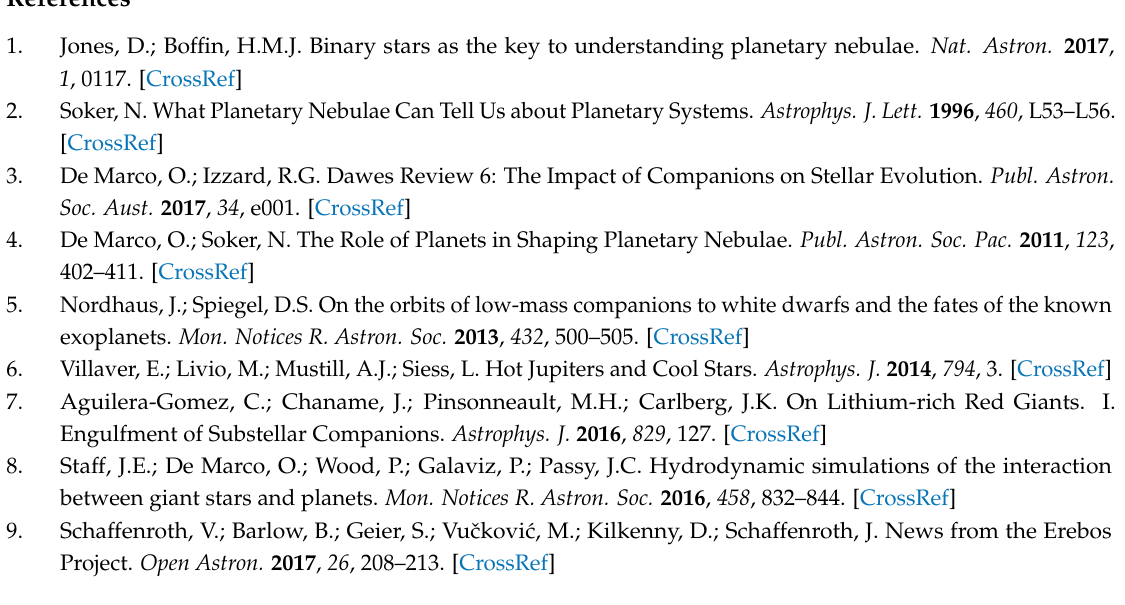
Figure 5. The evolutionary channels and the PN types that result from them (based on De Marco & Soker 2011